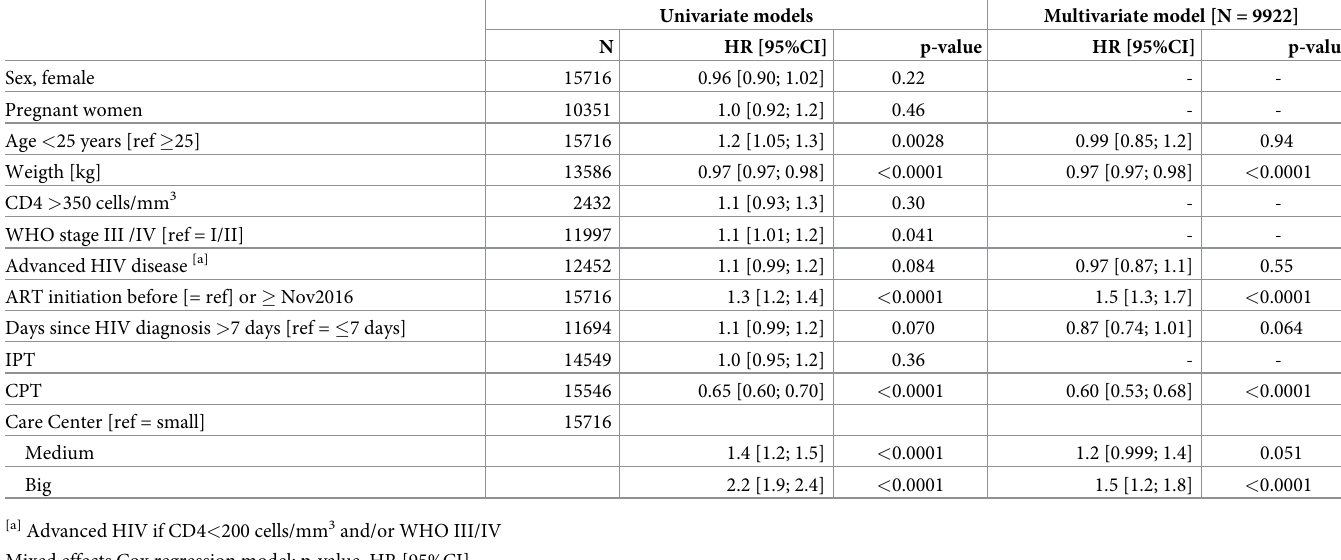
Table 3. Characteristics associated with retention: Mixed effects Cox regression models on probability of LTFU for the entire